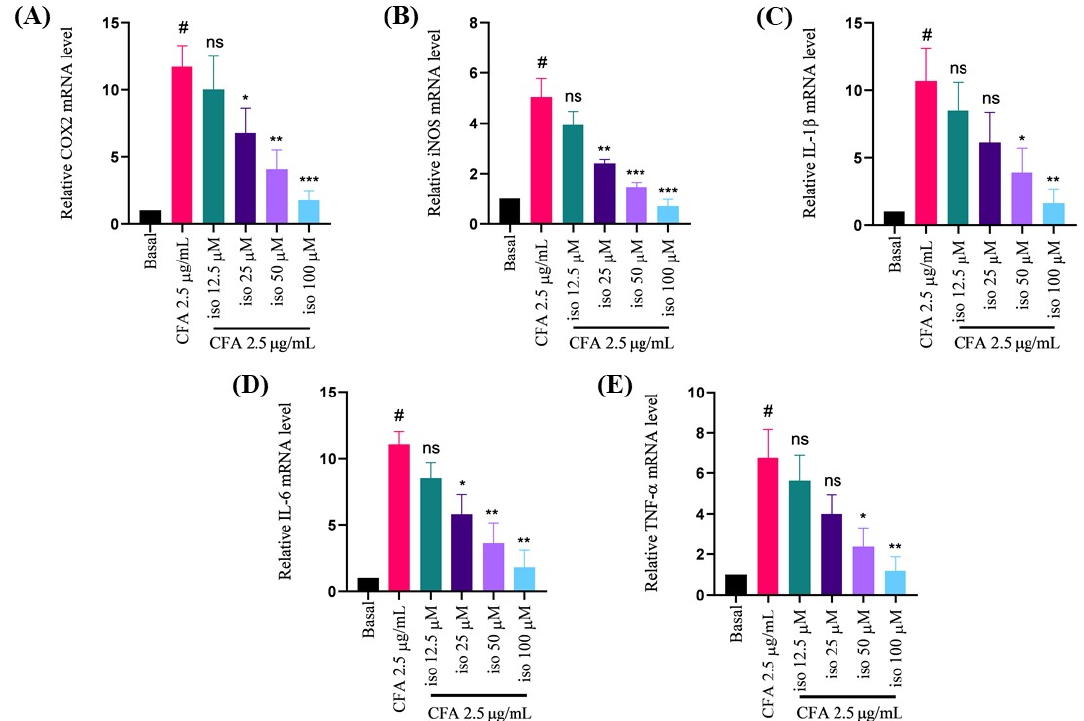
Figure 3. Effect of isoleucilactucin on CFA-induced mRNA expression in MH-S cells measured using real-time polymerase chain reaction (PCR). ( A – E ) The mRNA levels of COX2, iNOS, IL-1 β , IL-6, and TNF- α were analyzed by PCR after 18 h of incubation with CFA. Isoleucilactucin dosages of 12.5, 25, 50, and 100 µ M were used. GAPDH was used as a housekeeping gene. Values from the three independent experiments were expressed as the mean ± SEM ( n = 3). Compared with the basal group, # p < 0.001; compared with the CFA group, ns: not significant, * p < 0.05, ** p < 0.01, and *** p < 0.001.